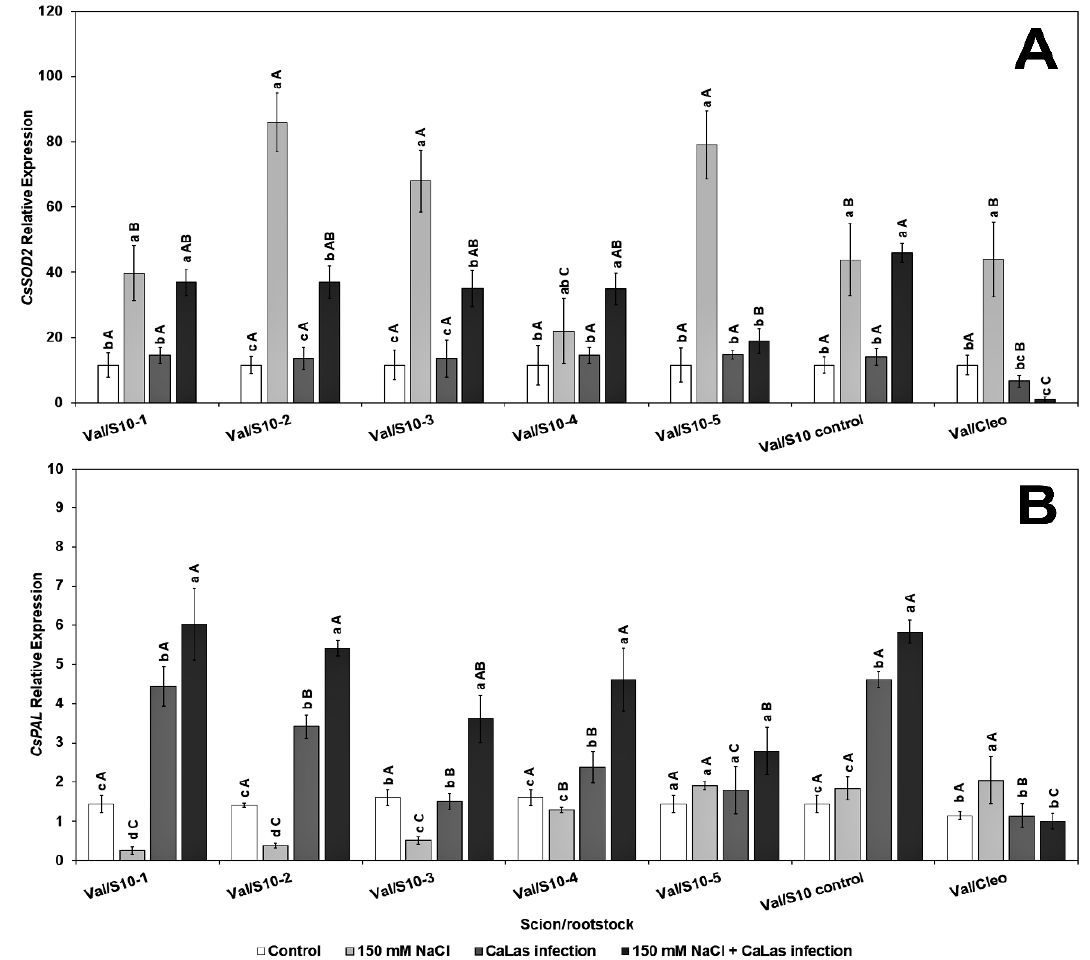
Figure 2. Effect of NaCl stress and Ca Las infection on ‘Valencia’ sweet orange scions grafted onto S10-derived rootstocks and Cleopatra mandarin (control). ( A ), CsSOD2 , ( B ), CsPAL . Bars represent means ± standard error. Mean separation between rootstocks at a particular treatment is indicated by differing uppercase letters; mean separation between treatments in a particular rootstock is indicated by differing lowercase letters by Tukey’s honestly significant difference test ( p ≤ 0.05).